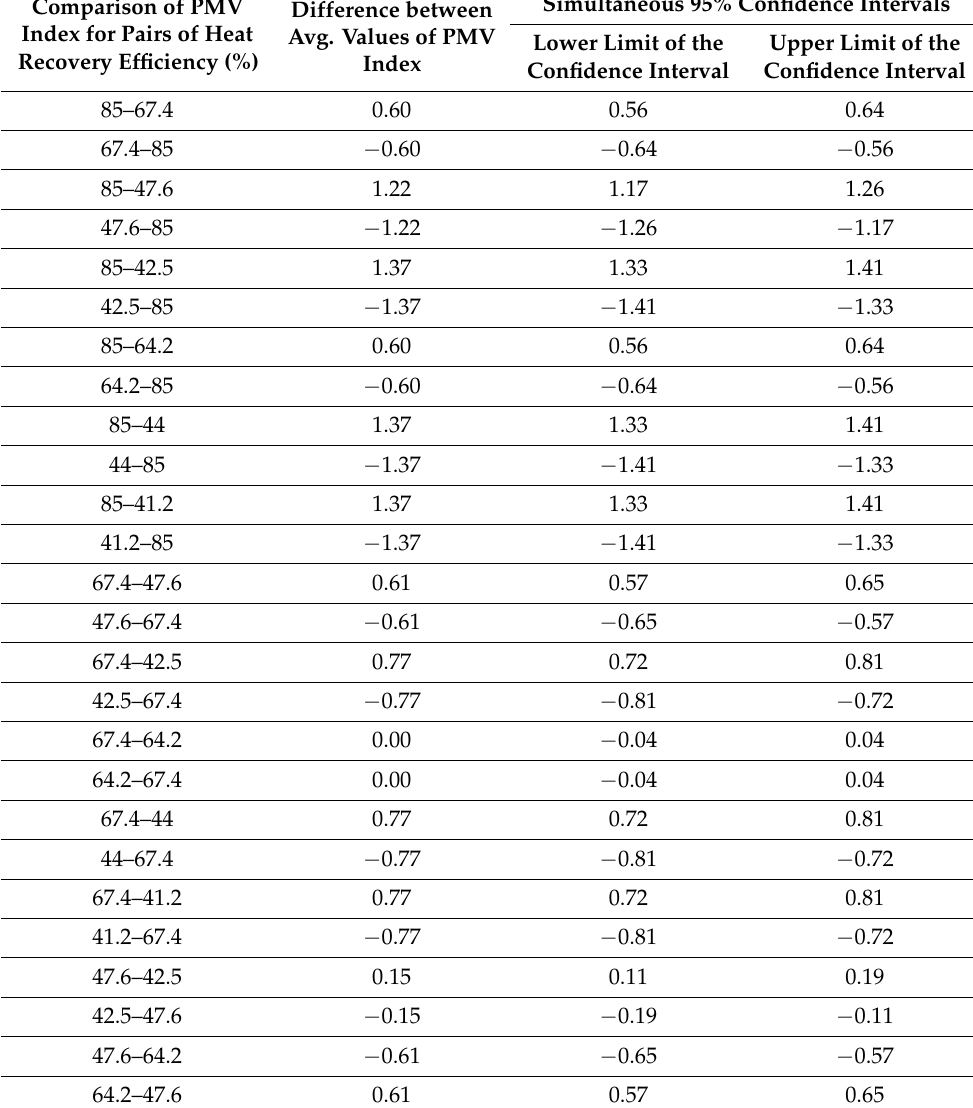
Table 6. Simultaneous 95% confidence intervals obtained using the Tukey method for difference